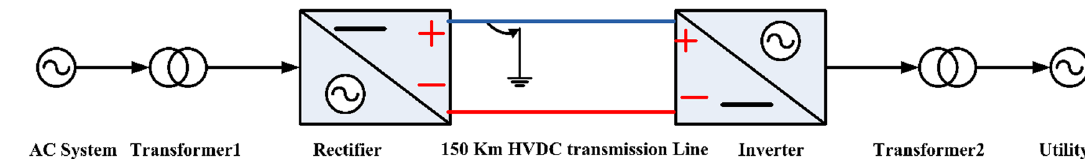
Fig. 2 Short circuit fault between positive and ground (PG) on an HVDC